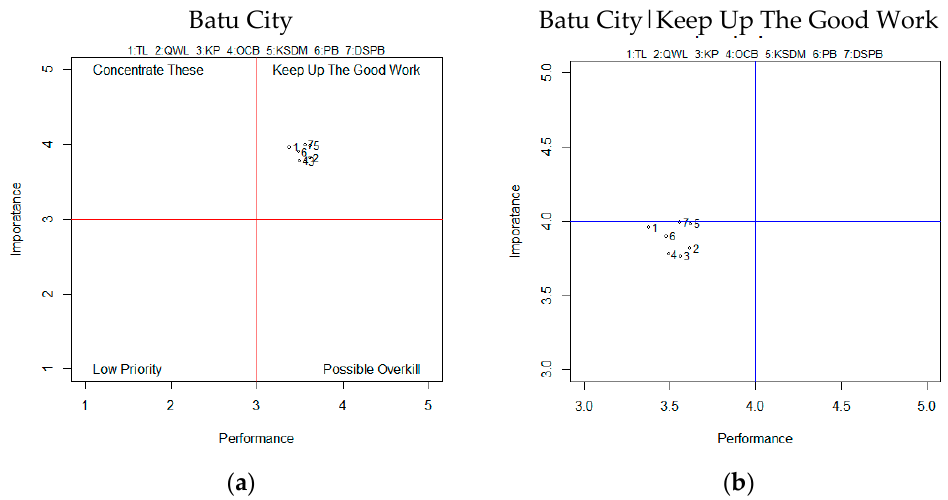
Figure 1. ( a ) IPA Cartesian Diagram of Batu City. ( b ) IPA Cartesian Diagram of Keep up the Good Work Quadrant of Batu City.